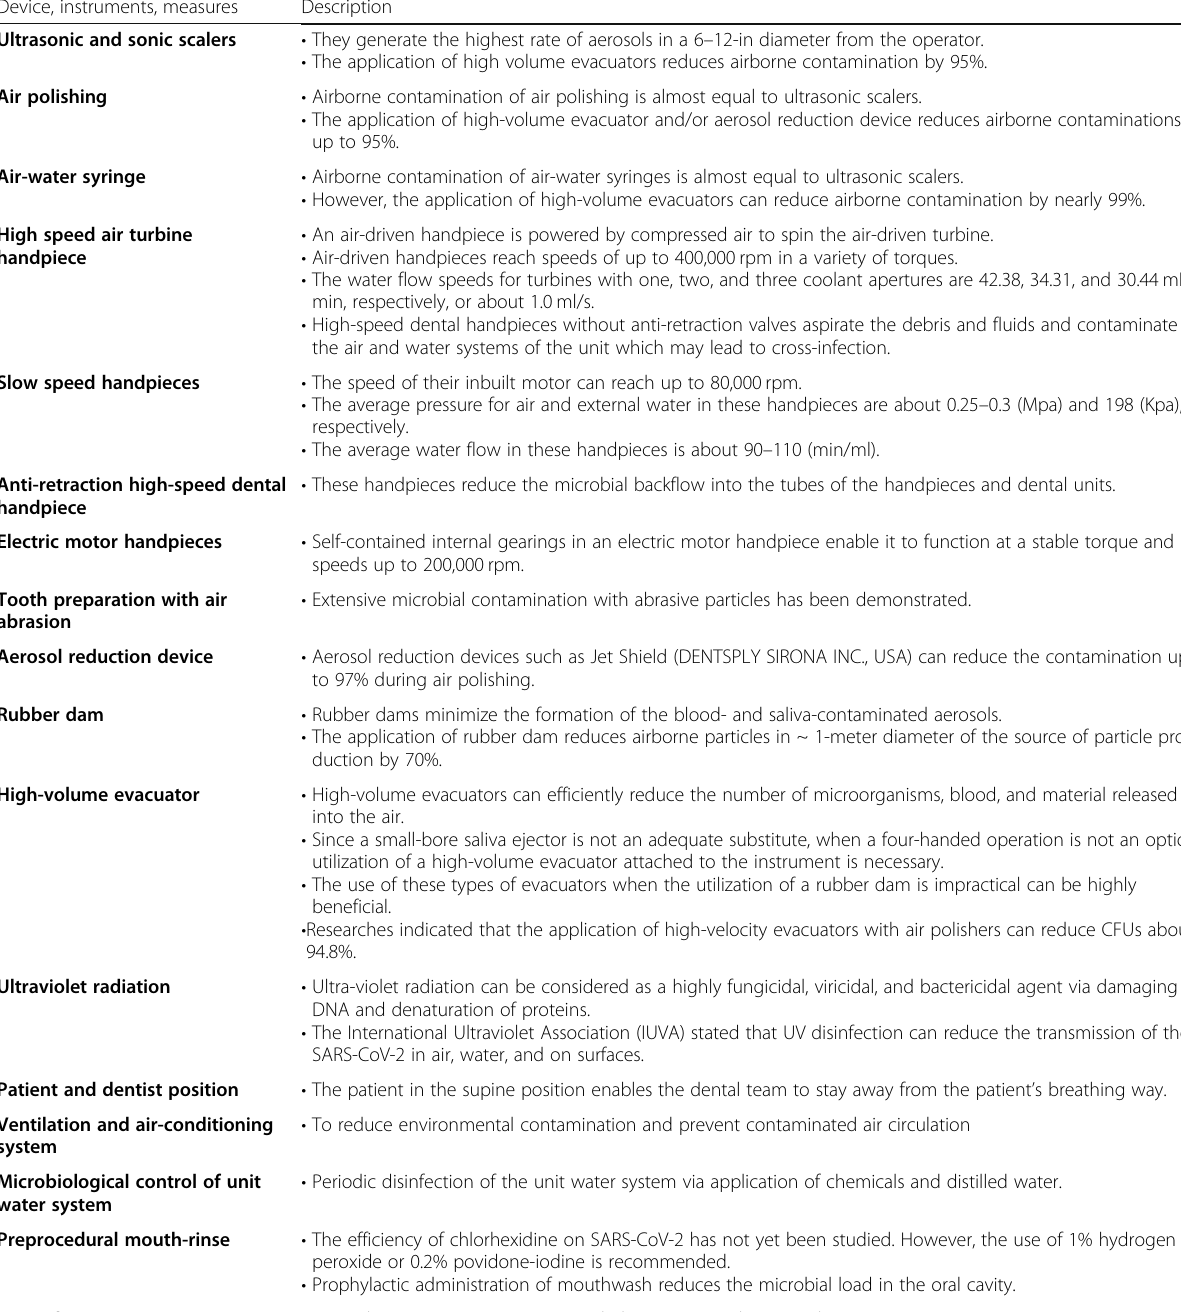
Table 1 Factors related to aerosol contamination Device, instruments, measures